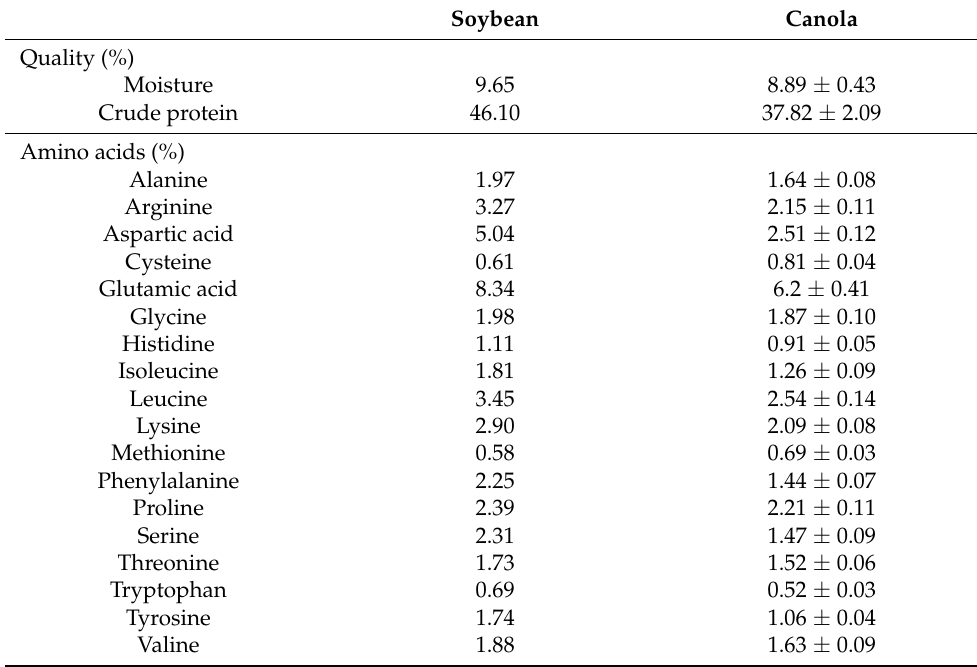
Table 2. Comparison of moisture content, crude protein, and amino acid profiles between soybean meal and western Canadian canola meal. Values presented for canola meal are the mean and standard deviations of samples collected from five different crushing plants across western Canada. The origin and variability of the soybean meal were not disclosed [68]. Soybean